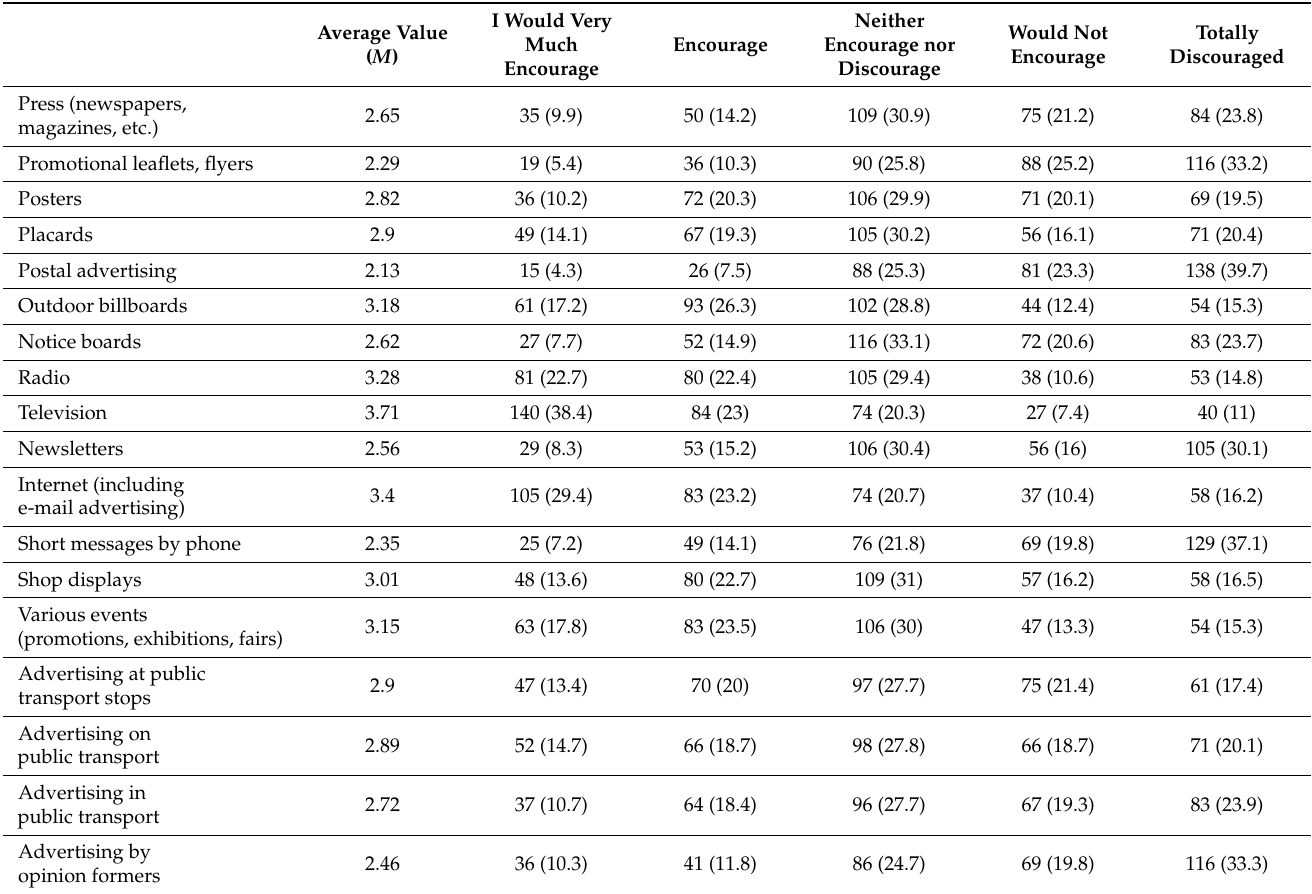
Table 7. Assessment of the means and channels through which advertising promotes sustainable mobility and